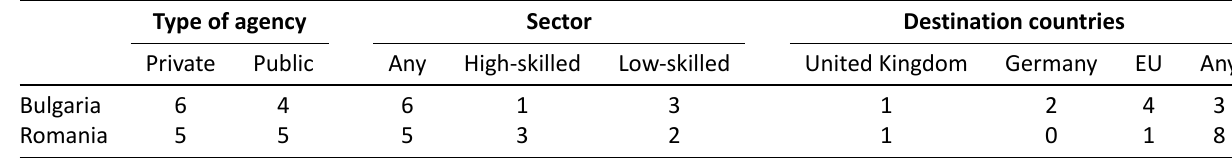
Table 1. Selection of recruiting agencies in the GEMM